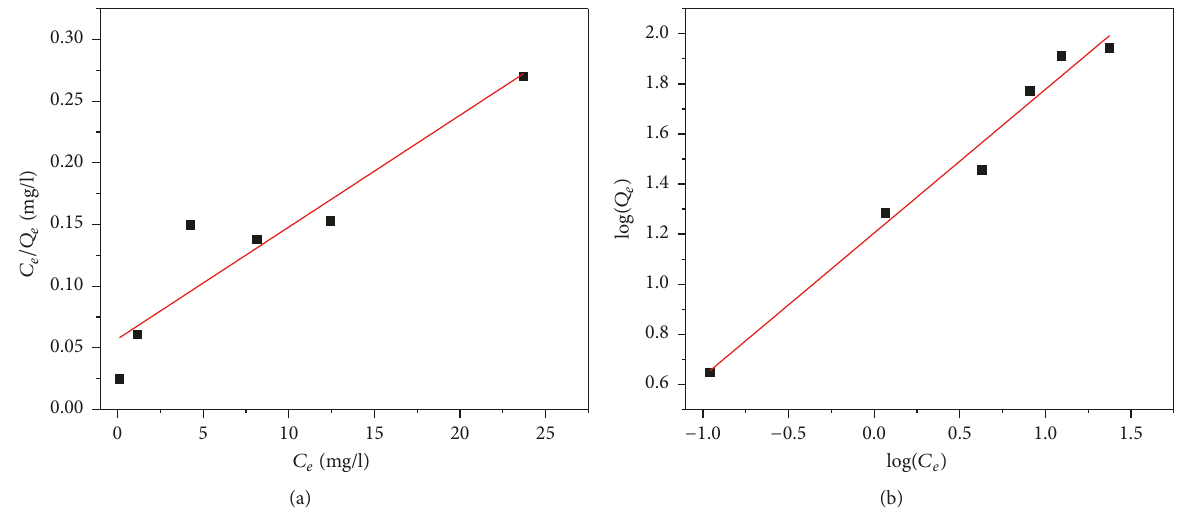
Figure 12: Adsorption isotherm models of selenium: (a) Langmuir and (b) Freundlich.